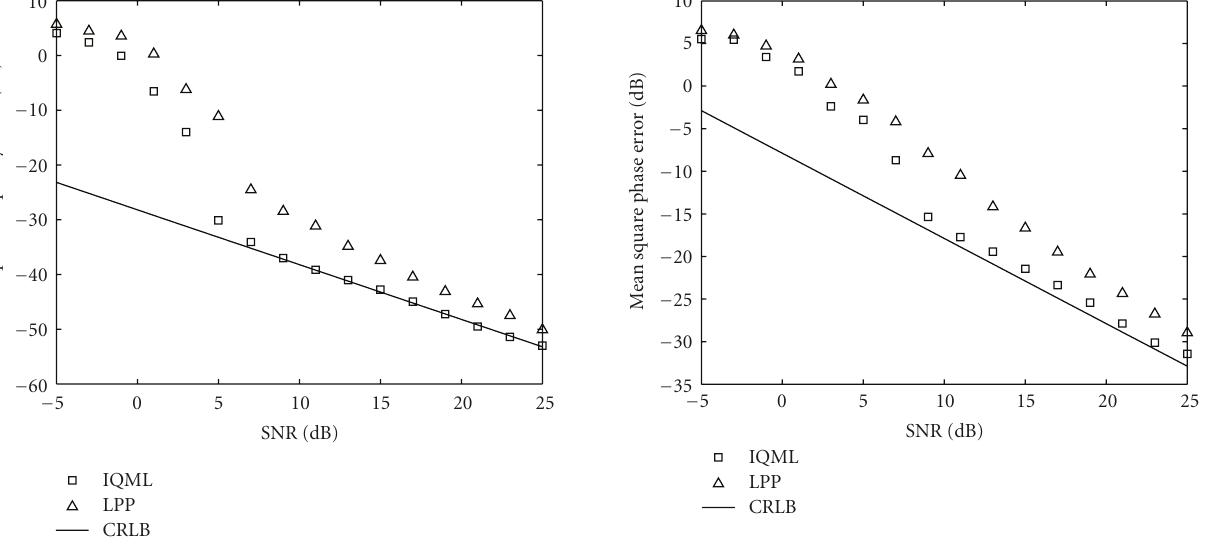
Figure 20: MSE for φ 1 of multiple complex sinusoids.